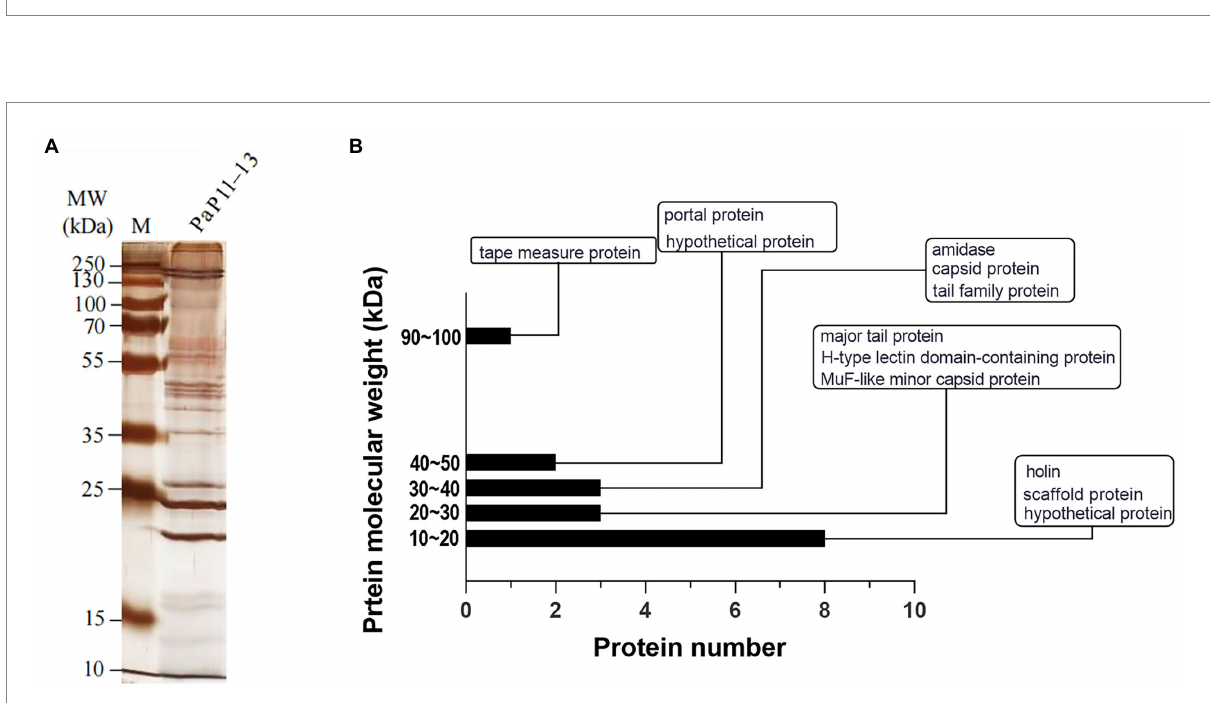
FIGURE 7 (A) SDS-PAGE, (B) Protein analysis of φ PaP11-13. The molecular weight histogram of protein. The ordinate is the molecular weight of the protein, and the abscissa is the number of proteins. The indicator lines classify and label